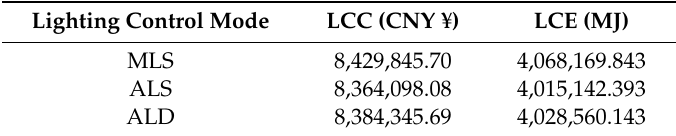
Table 4. Information about the fifth design with three lighting control modes.